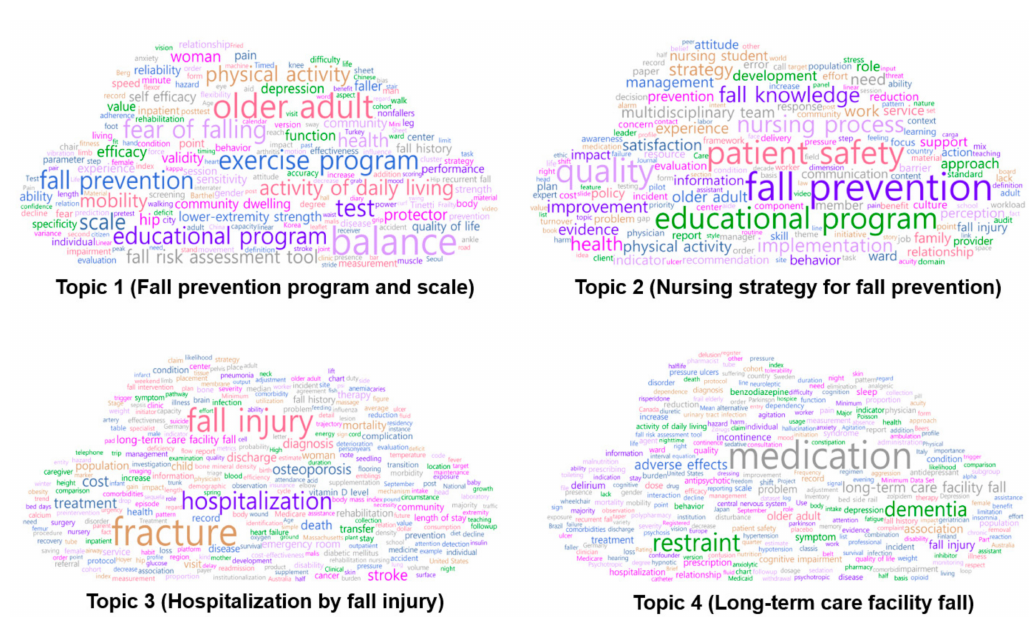
Figure 3. Word clouds by